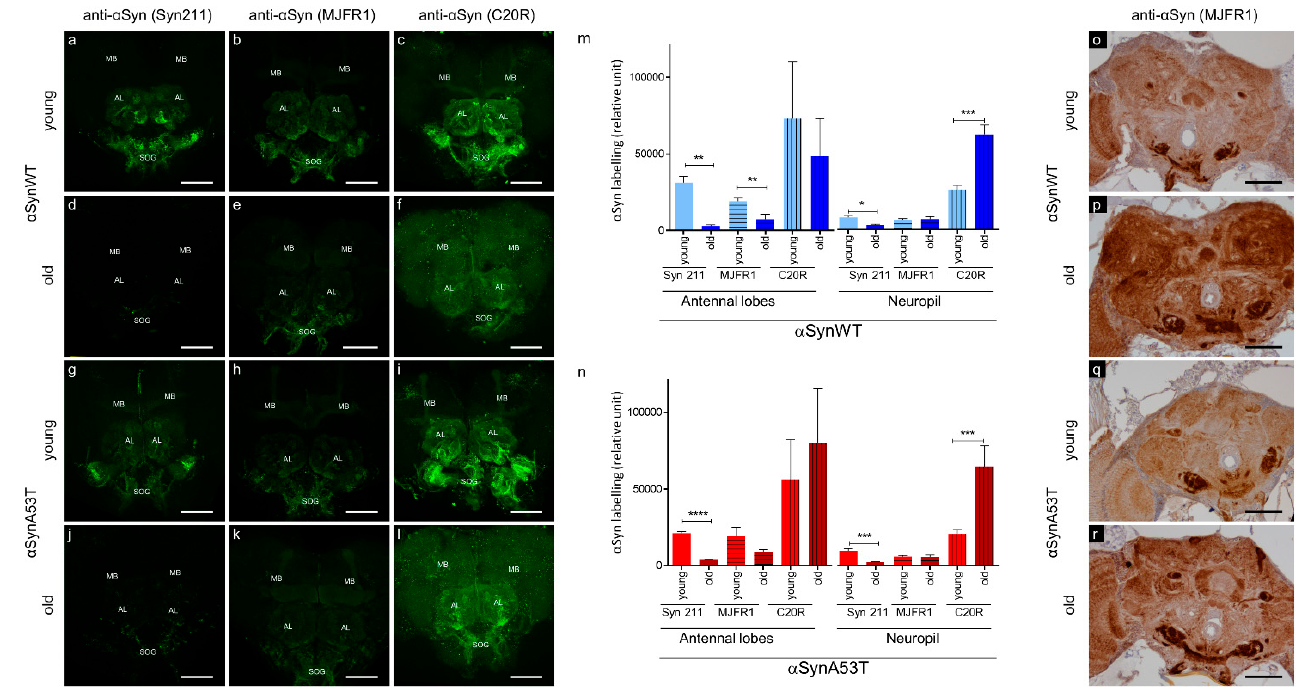
Figure 1. α Syn transgenic flies show an age-dependent α Syn epitope-masking. Representative immunofluorescence or immunohistochemistry brain images of young (5-day-old for immunofluorescence or 10-day-old for immunohistochemistry) ( a – c , g – i , o , q ) or old (60-day-old) ( d – f , j – l , p , r ) flies expressing human α synWT ( a – f , o , p ) or α synA53T ( g – l , q , r ) under the ELAV driver. Flies were raised on standard corn meal food supplemented with yeast. For immunofluorescence images, α Syn was stained (indicated in green) with different α Syn-specific antibodies: Syn 211 ( a , d , g , j ), MJFR1 ( b , e , h , k ) or C20R ( c , f , i , l ) on dissected fly brains of young and old flies. Images were projected from confocal Z-stacks acquired on confocal microscope using MAX intensity method. Note a prominent staining of the α Syn in the mushroom bodies (MB), cell bodies of the antennal lobes (AL) and suboesophageal ganglions (SOG). Quantifications of fluorescence were determined after z- projection (using SUM intensity method) on selected regions of interest (antennal lobes or in neuropils of the anterior ventrolateral protocerebrum) for flies expressing human α synWT ( m ) or α synA53T ( n ). Data are shown as mean with standard deviation for the three different α Syn-specific antibodies for young or old flies from two independent experi- ments: Syn211 (n = 5 for α synWT and n = 6 for α synA53T in antennal lobes ; n = 5 for α synWT and n = 6 for α synA53T in neuropil), MJFR1 (n = 6 for α synWT and n = 6 for α synA53T in antennal lobes ; n = 7 for α synWT and n = 6 for α synA53T in neuropil) and C20R (n = 7 for α synWT and n = 9 for α synA53T in antennal lobes ; n = 7 for α synWT and n = 8 for α synA53T in neuropil). p -values of the group differences were calculated using t test (** p = 0.0026 ( α synWT, antennal lobes, Syn211), ** p = 0.0070 ( α synWT, antennal lobes, MJFR1), **** p < 0.0001 ( α synA53T, antennal lobes, Syn211), * p = 0.0138 ( α synWT, neuropil, Syn211), *** p = 0.0002 ( α synWT, neuropil, C20R), *** p = 0.0009 ( α synA53T, neuropil, Syn211) and *** p = 0.0006 ( α synA53T, neuropil, C20R), respectively). Immunohistochemistry was performed using MJFR1 anti- body ( o – r ) with antigenic unmasking protocol and revealed an accumulation of α Syn in older flies. Scale bar, 30 µm. 2.2. Developing Biochemical Assays to Follow α Syn Pathology during Aging in Drosophila Previous studies have also shown that the process of α Syn aggregation is associated with the accumulation of α Syn fibrils that are resistant to mild proteolysis by Proteinase K [49]. The accumulation of proteinase-K resistant forms of α Syn was also observed in flies carrying a deficiency in the Drosophila homolog of the glucocerebrosidase 1 (GBA1) gene [27]. Therefore, we examined whether α Syn resistance to proteinase-K digestion var- ied during fly aging. We found an age-dependent increased accumulation of proteinase- K resistant forms of α Syn in both transgenic Drosophila expressing α SynWT and α SynA53T with the ELAV driver (Figures 2a,b and S1). We also observed that the sensi- tivity to proteinase-K digestion was higher in Drosophila expressing α SynWT compared to the one expressing α SynA53T, suggesting that α Syn protein carrying mutation A53T may be more prone to aggregate. The concentration of proteinase-K for which α Syn was degraded ranged from 0.5 to 1 μ g/mL of proteinase-K and 1 to 1.5 μ g/mL of proteinase-K